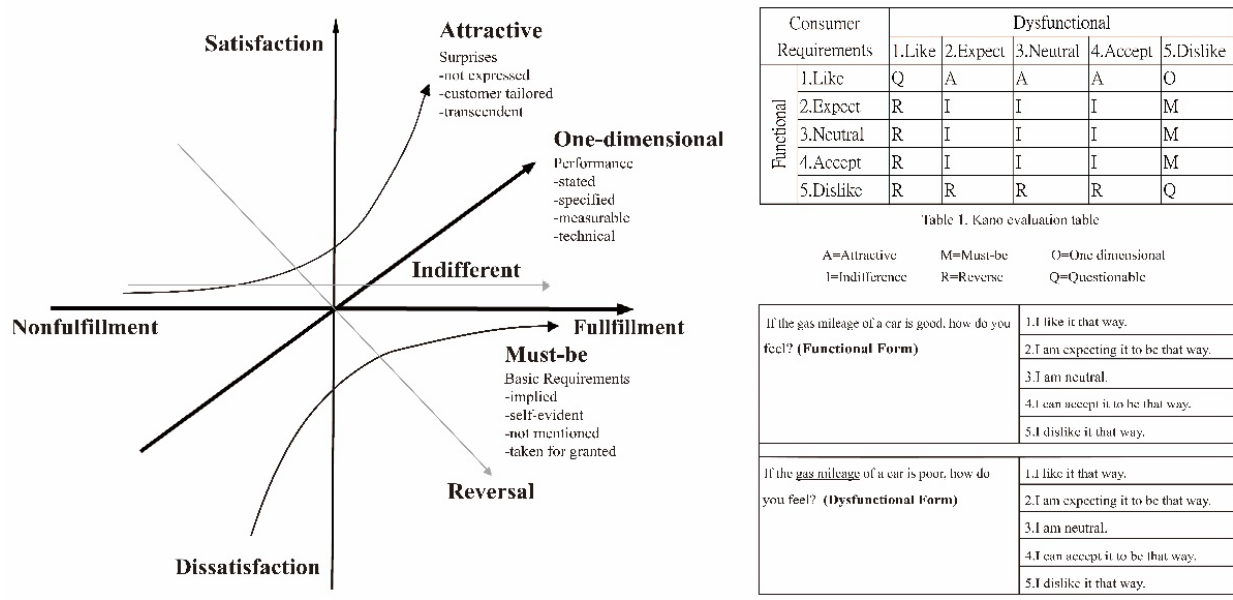
Figure 2. The Kano Model’s theoretical framework and an example of the questionnaire design